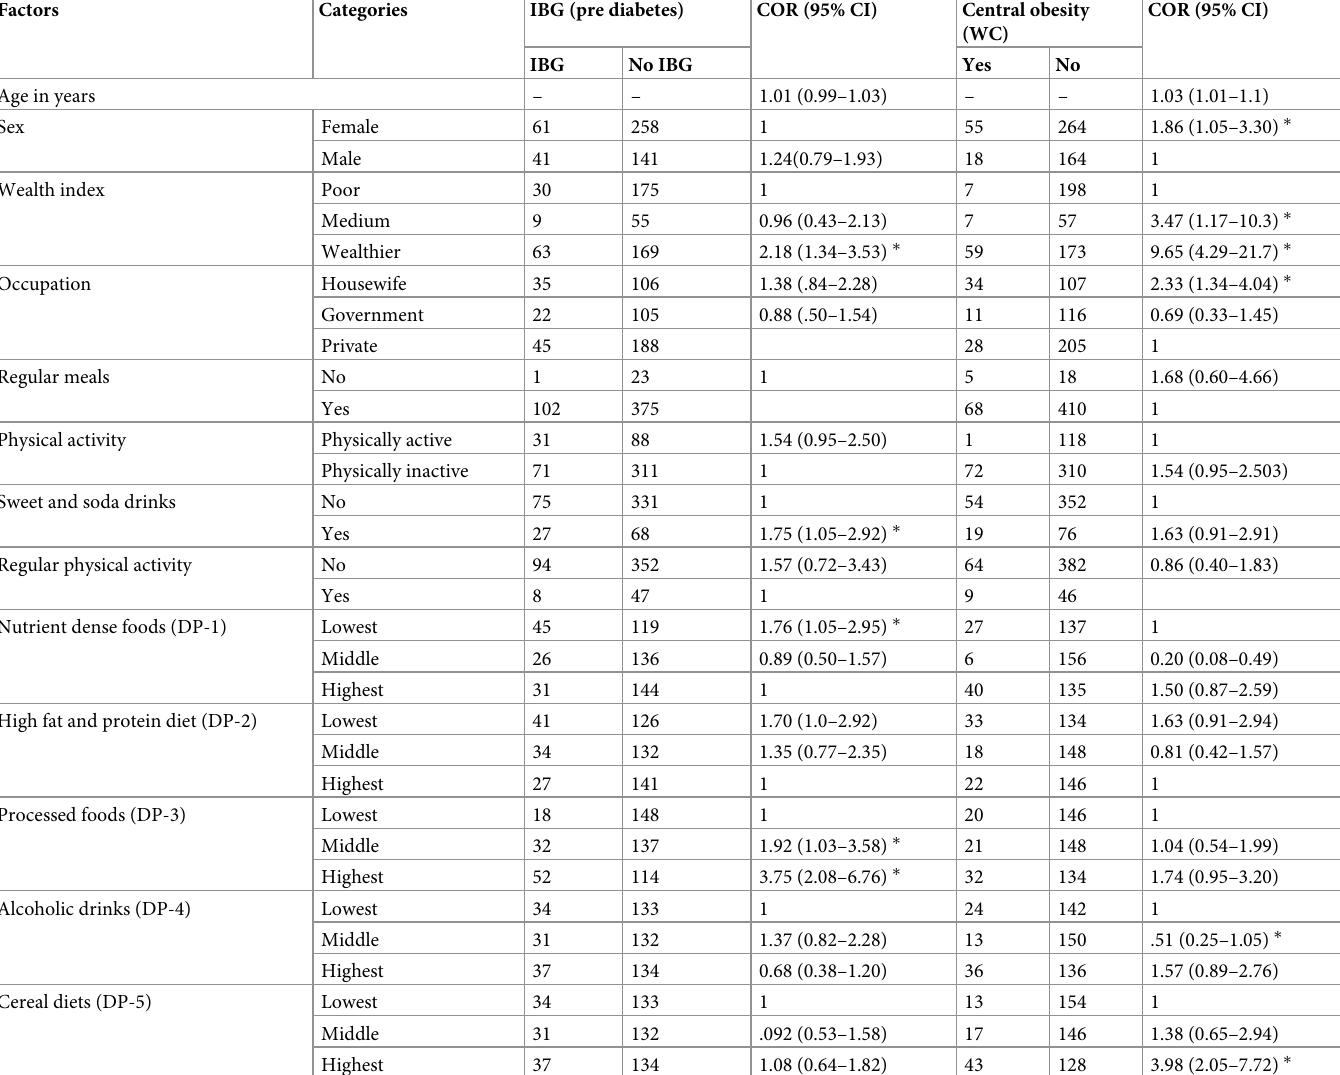
Table 3. Bivariable logistic regression output for determinants of IBG and central obesity among adults from Dire Dawa and Harar, Eastern